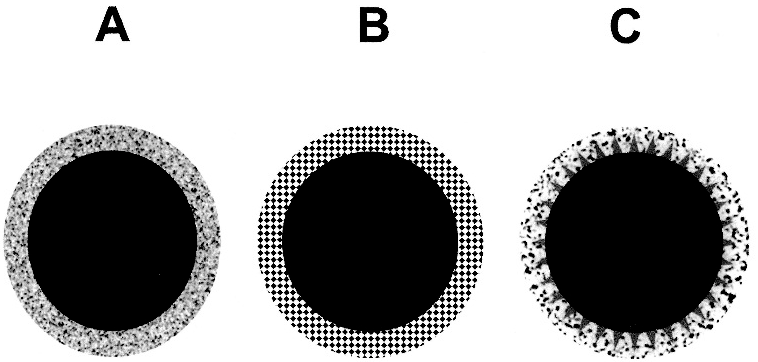
Figure 6. Model superficially porous silica gels. A: synthesized porous silica gel on the surface of nonporous core silica gel. B: small nonporous silica gels are attached on the surface of nonporous core silica gel. C: etching the dense surface porous silica gel or whisker silica gels to increase the pore size.